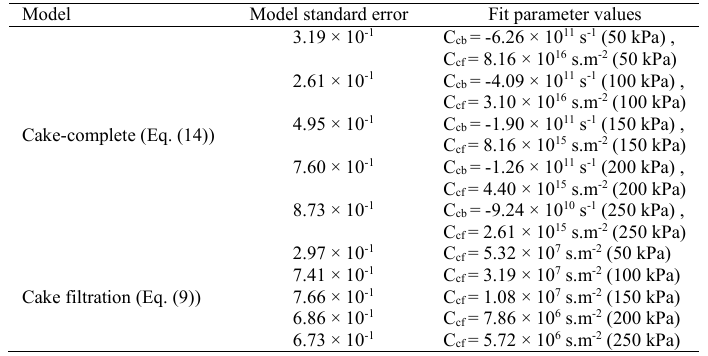
Table 2: Combined cake filtration-complete blocking and cake filtration model standard error values and fitted parameters of skim milk concentration using spiral wound ultrafiltration membrane module at different TMPs. Model Model standard error